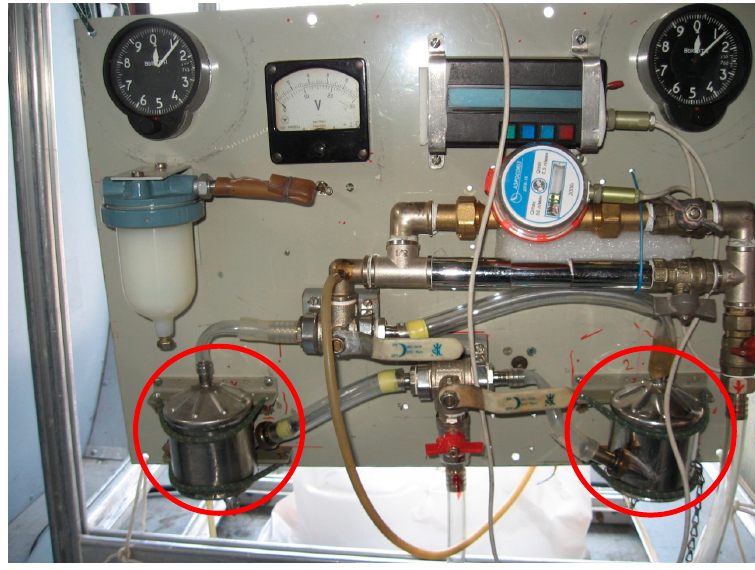
Figure 4. Photo of two impingers (red circles) at a sampling stand of microorganisms located in atmospheric aerosol.